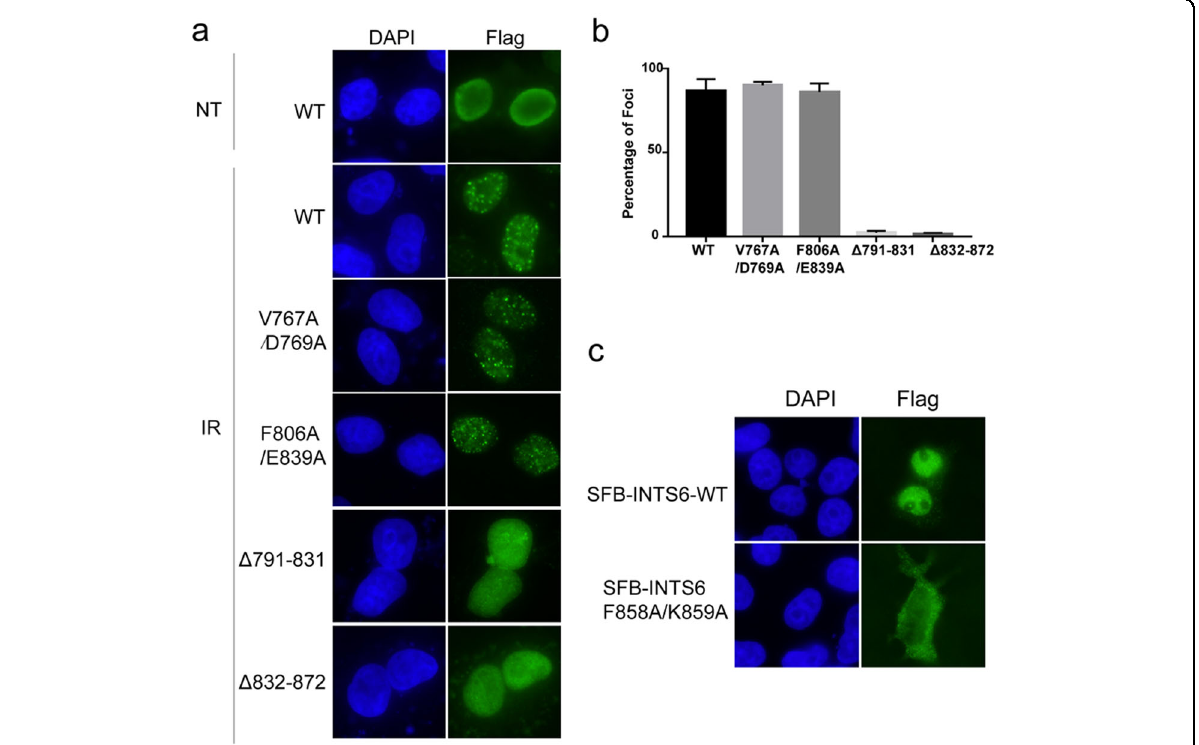
Fig. 3 The effects of INTS3 dimerization and its interaction with INTS6 on INTS3/INTS6 recruitment to DSB sites. a Cells transfected with SFB- tagged wild-type INTS3 or its mutants were treated with IR (10 Gy) for 6 h or left untreated. Cells were then fi xed and processed for immuno fl uorescence with an anti-Flag antibody. b The quanti fi cation of foci-positive cells was performed by counting a total of 300 cells per sample. c Cells transfected with SFB-tagged wild-type INTS6 or the F858A/K859A mutant were fi xed and processed for immuno fl uorescence with anti-Flag